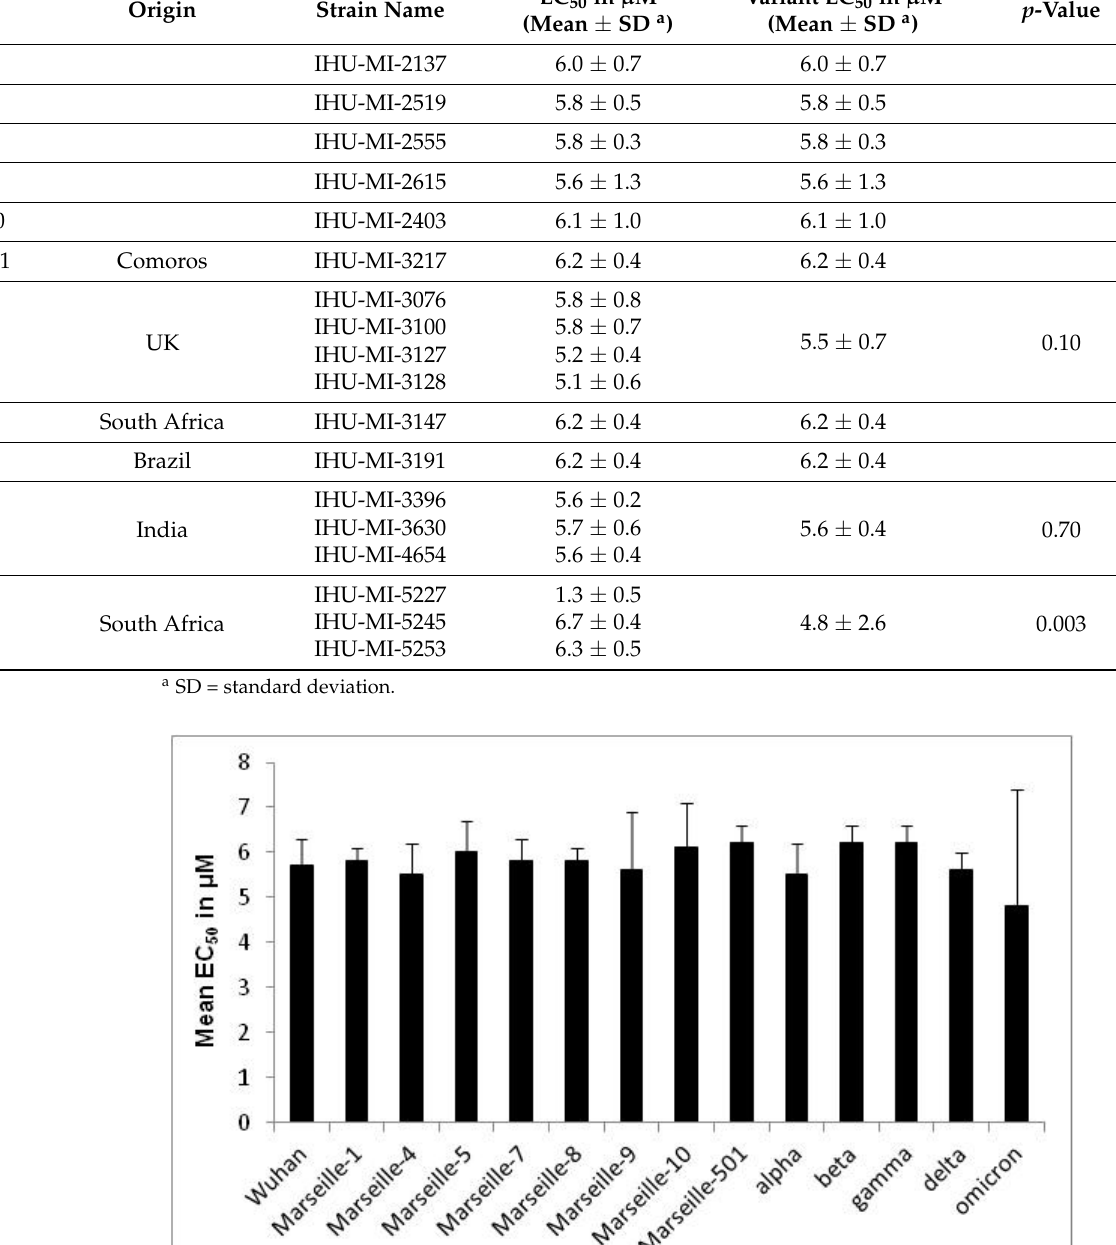
Figure 1. EC 50 means of ivermectin according to the 14 clinically isolated variants of SARS-CoV-2 (error bar represents the standard deviation of 5 to 11 independent experiments).